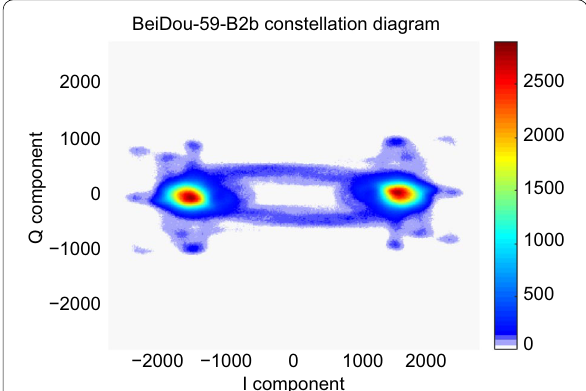
Fig. 10 Constellation when BDS-3 GEO-1 PPP-B2b is received